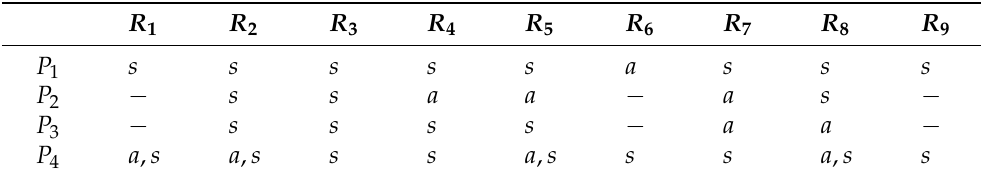
Table 1. The type of the equilibria P 1 , P 2 , P 3 and P 4 on different regions from bifurcation diagrams; s stands for saddle, while a for